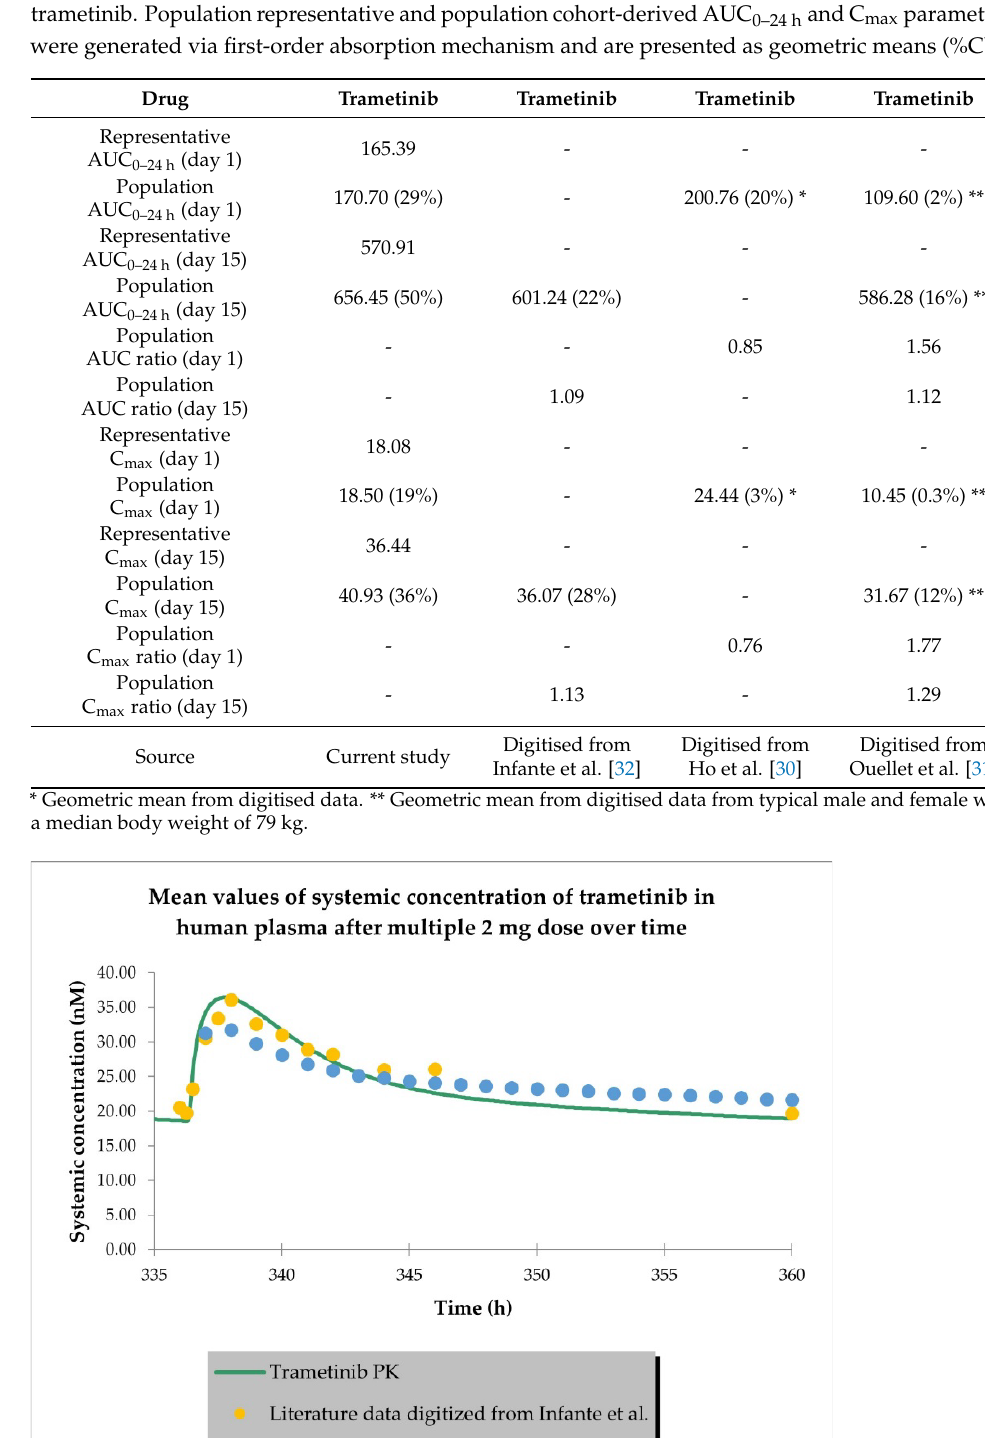
Table 3. Comparison of predicted vs. observed key PK parameters (AUC 0–24 h and C max ) for trametinib. Population representative and population cohort-derived AUC 0–24 h and C max parameters were generated via first-order absorption mechanism and are presented as geometric means (%CV). Drug Trametinib Trametinib Trametinib